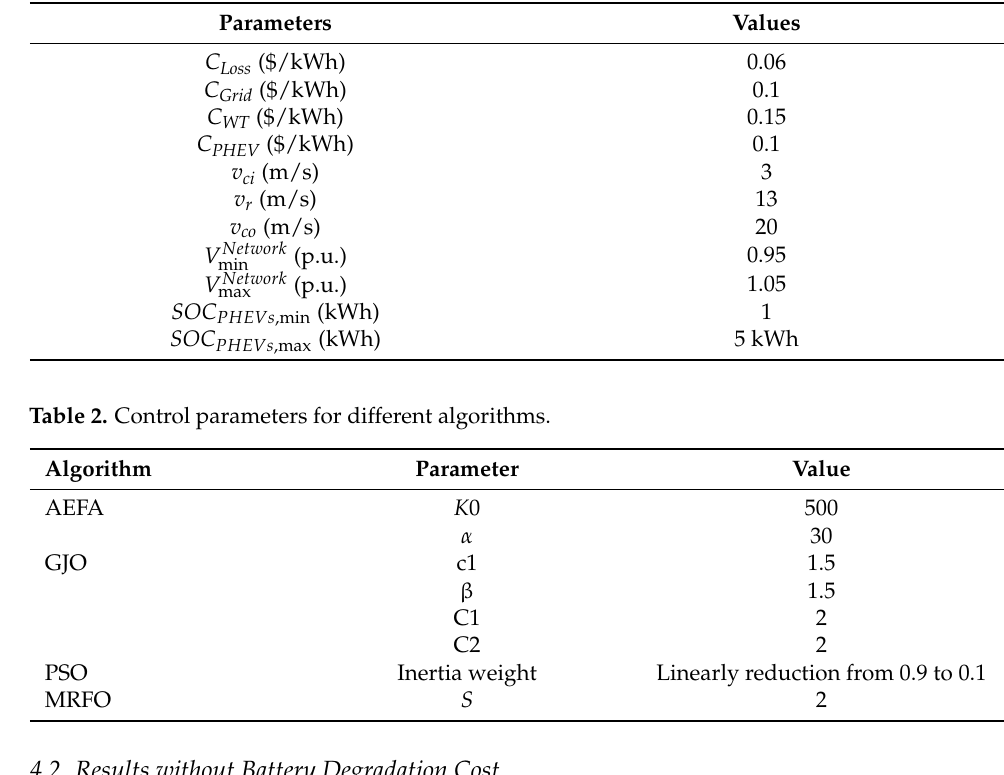
Table 1. Technical-economic data on wind turbines, electric parking, and network.